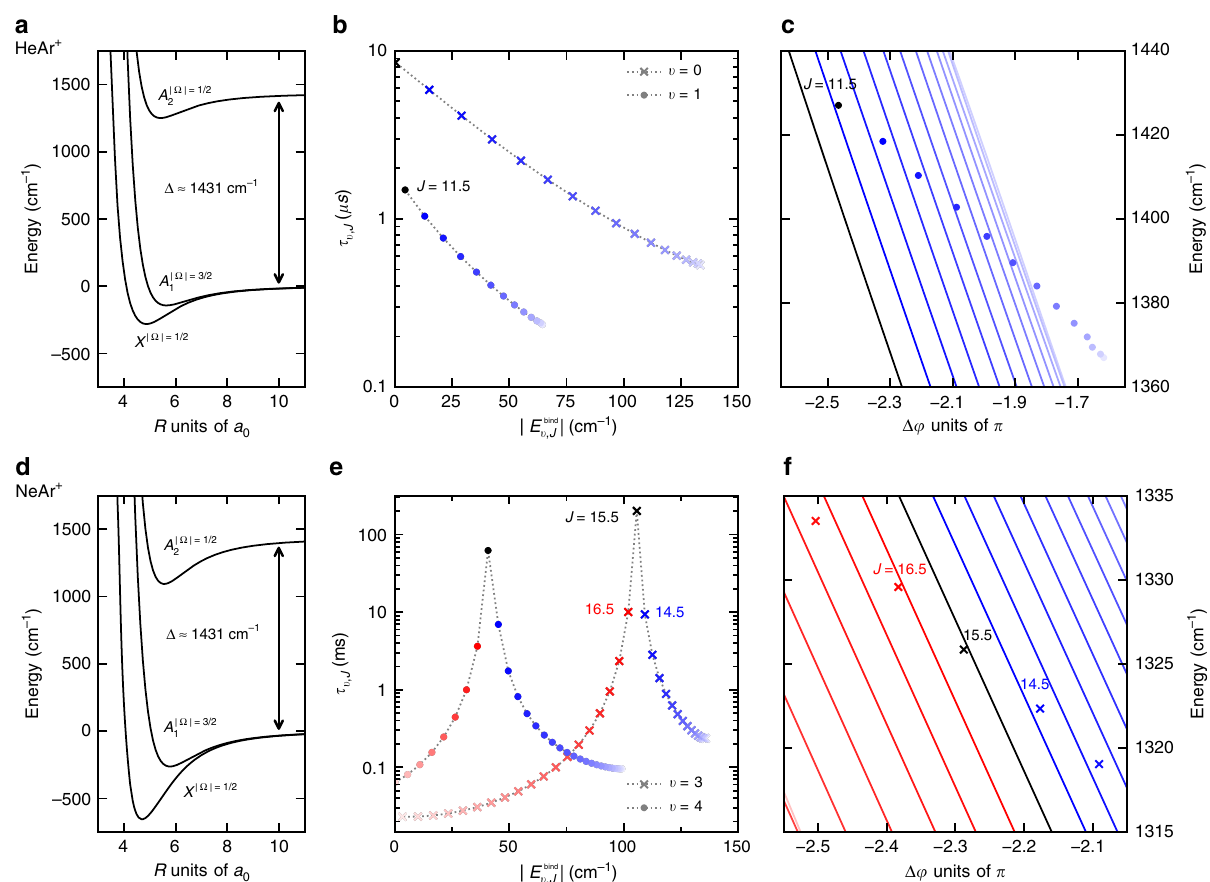
Fig. 2 Rovibrational FFR in spin – orbit excited noble gas dimers. Potential energy curves ( a , d ) lifetimes of A 2 state rovibrational levels, obtained with full account of non-perturbative effects, as a function of binding energy ( b , e ) and zero-overlap lines resulting in phase protection for fi xed v and different J , as a function of scattering phase and energy ( c , f ) for HeAr + ( a – c ) and NeAr + ( d – f